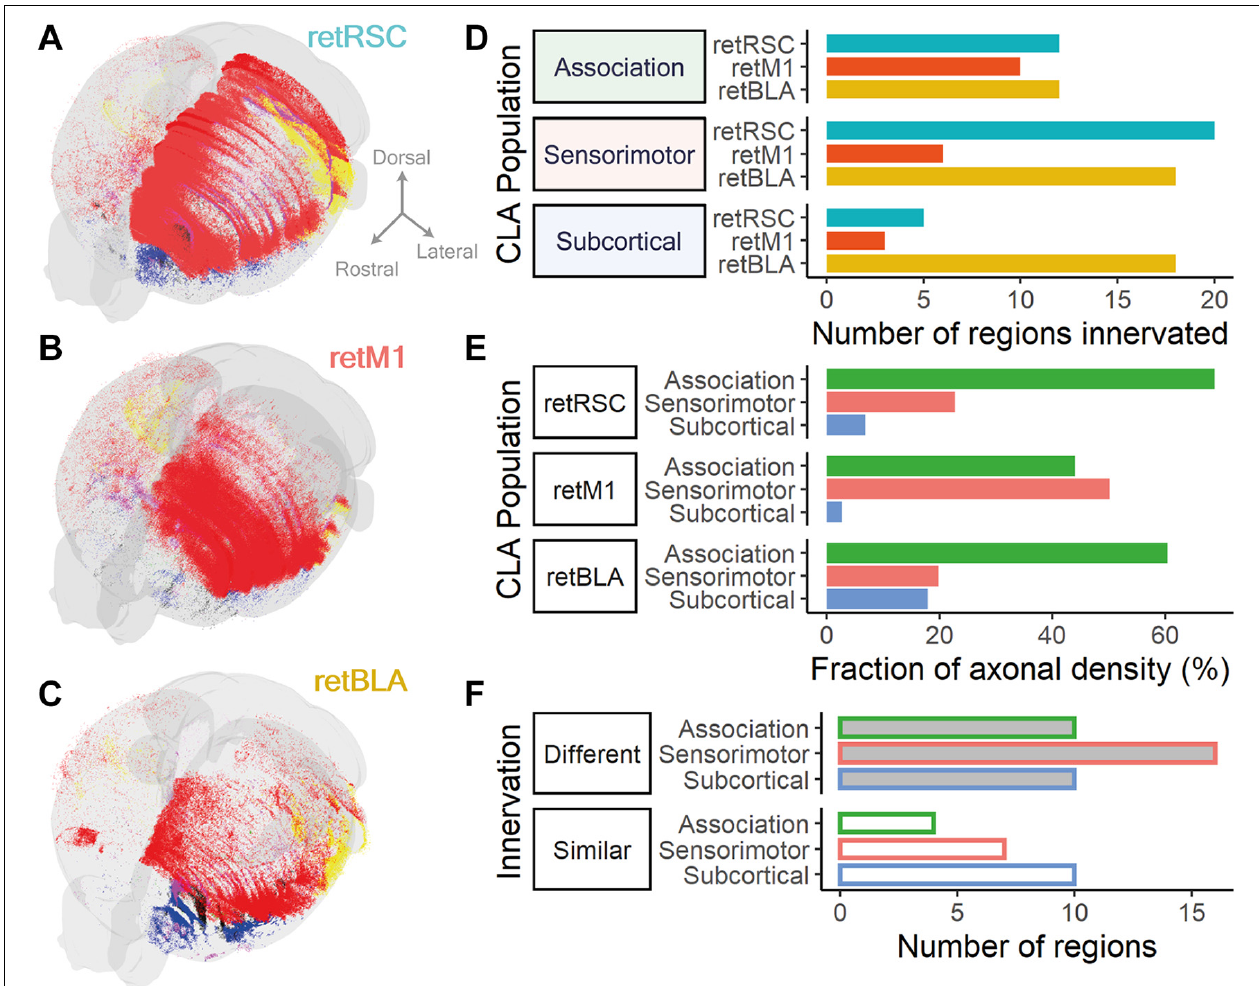
FIGURE 9 | CLA neurons projecting to RSC, BLA, and M1 form different projection distributions and differ most heavily in sensorimotor innervation. (A–C) 3D reconstruction of fiber densities as point clouds; colors represent different broad region categories: Cortex, red; Olfactory, blue; and Hippocampal formation, yellow. (A) From RSC-projecting CLA neurons (retRSC). (B) From M1-projecting CLA neurons (retM1). (C) From BLA-projecting CLA neurons (retBLA). (D) Fraction of axonal density from each CLA projection population split into association (green), sensorimotor (red), and subcortical (blue) categories.The distribution of axonal densities across the different categories differed between the three CLA populations. (E) Number of regions innervated by each CLA projection population grouped by broad region categories: Association, sensorimotor and subcortical. Only regions with mean axonal density >0.002 of the total were considered to be innervated. Colors represent different CLA populations: retRSC in teal, retM1 in orange, retBLA in yellow. The number of innervated regions was similar for association cortices between all three CLA populations but differed for the sensorimotor and subcortical categories. (F) The number of regions in each broad region category that had different (top, shaded bar) or similar (bottom, open bar) innervation by all three CLA populations. The difference in innervation was determined by statistical testing using ANOVA to compare axonal densities from each CLA neuron population to each innervated brain region. Colored border represents different broad region categories: Association in green, sensorimotor in red, and subcortical in blue. The number of regions that had different innervation between CLA populations was higher than the number of regions that had similar innervation for association and sensorimotor cortices, but were equal in number for the subcortical